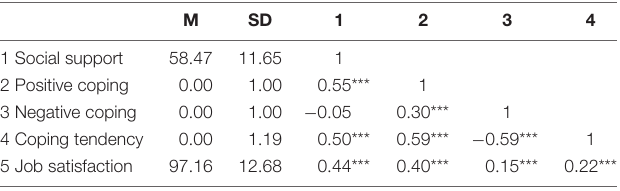
TABLE 1 | Descriptive statistics and correlations between the observed